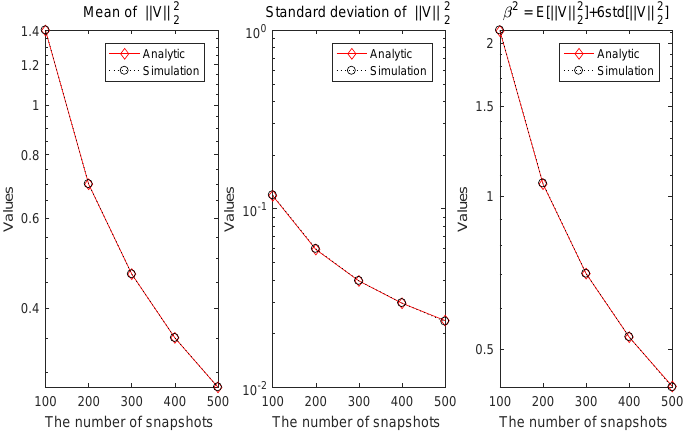
Figure 6. Comparison between the results of the analytic derivation and the results of Monte Carlo simulation (the number of elements of the transmitter = 14, the number of elements of the receiver = 10).